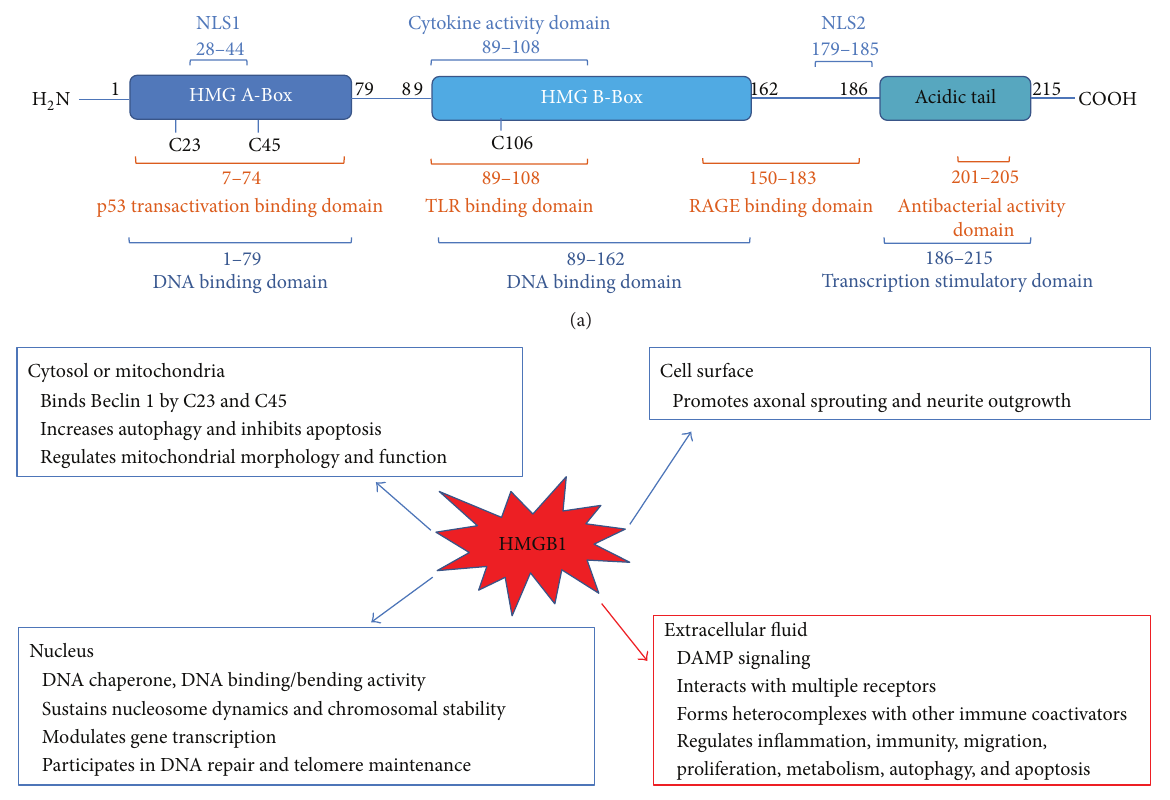
Figure 1: Multiple roles of HMGB-1 in cell